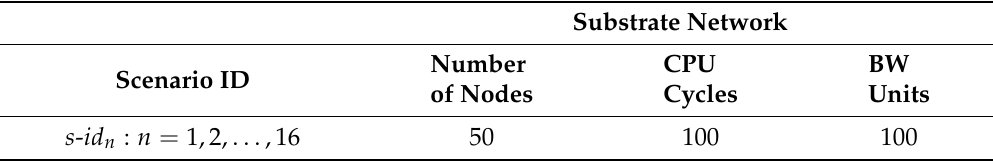
Table 3. Values of the physical parameters.